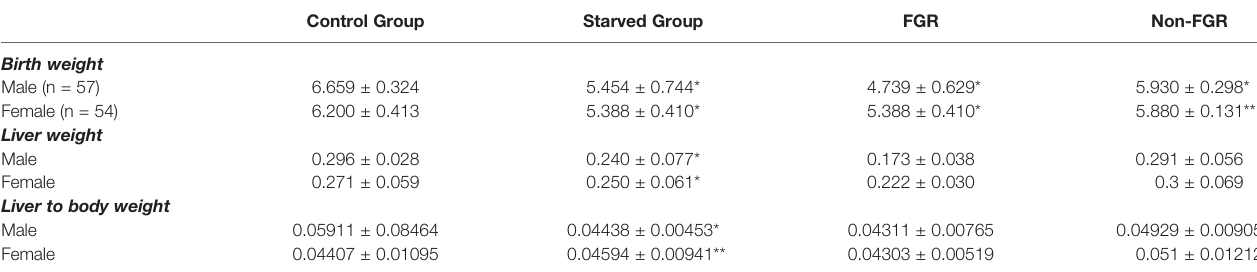
TABLE 2 | Birth and liver tissue mean weights of the newborn pups in control, food restricted group and both subcategories of starved group.